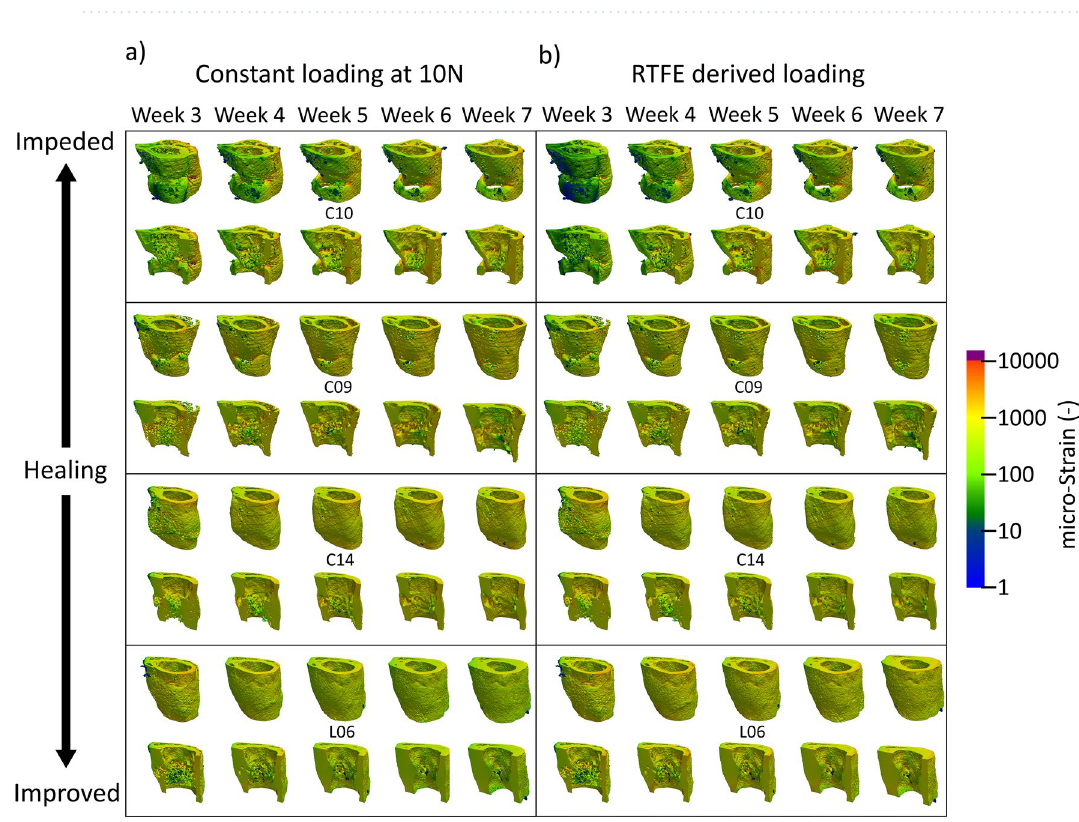
Figure 3. Longitudinal and cross-sectional strain progression under constant loading and rtFE adaptation simulations results show the progression of strain within the bone tissue. ( a ) demonstrates how poorly healed bones have less consistent strain distributions throughout the tissue, with regions of dangerously high strain and regions of lower strains. Well-healed bones however show a decrease in the strains throughout the tissue, as is the case in L06. ( b ) rtFE adapts the loading to ensure no peak strain voxels exist (C10) and maintains consistent strain fields (L06). For mice with smaller changes in bone geometry (C09 and C14), the adaptation is less obvious, but still